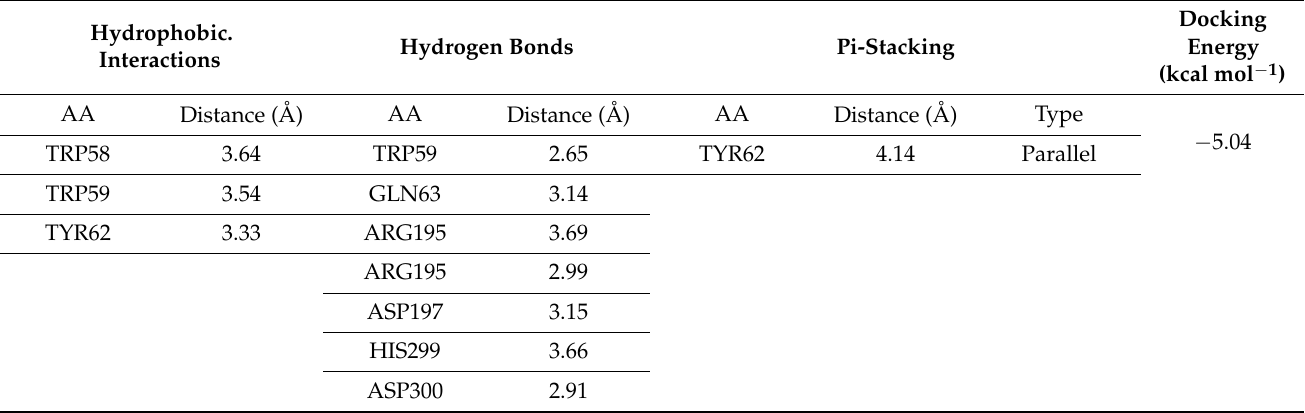
Table 6. Molecular docking parameters for p-coumaric acid–pancreatic α - amylase interactions obtained through